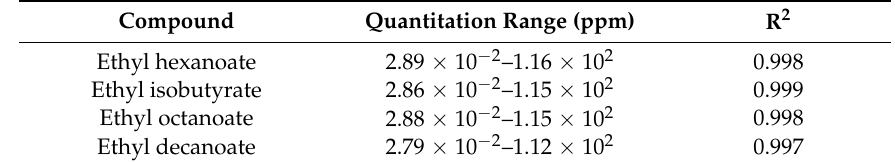
Table 3. Quantitation range and linear coefficients of determination for 5 key aroma compounds in wine.